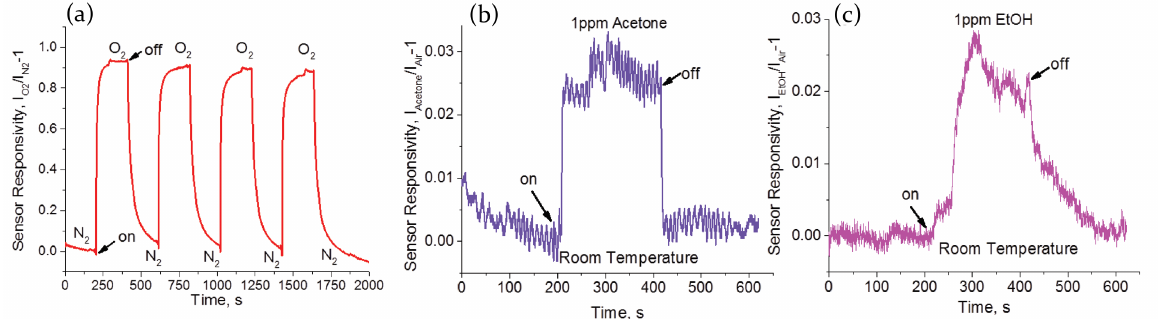
Figure 19. Dynamic CsPbBr 3 sensor responsivity to ( a ) O 2 , ( b ) acetone and ( c ) ethanol exposure at room temperature under visible-light irradiation. Adapted with permission from [104]. Copyright © 2017, WILEY-VCH Verlag GmbH and Co. KGaA, Weinheim.